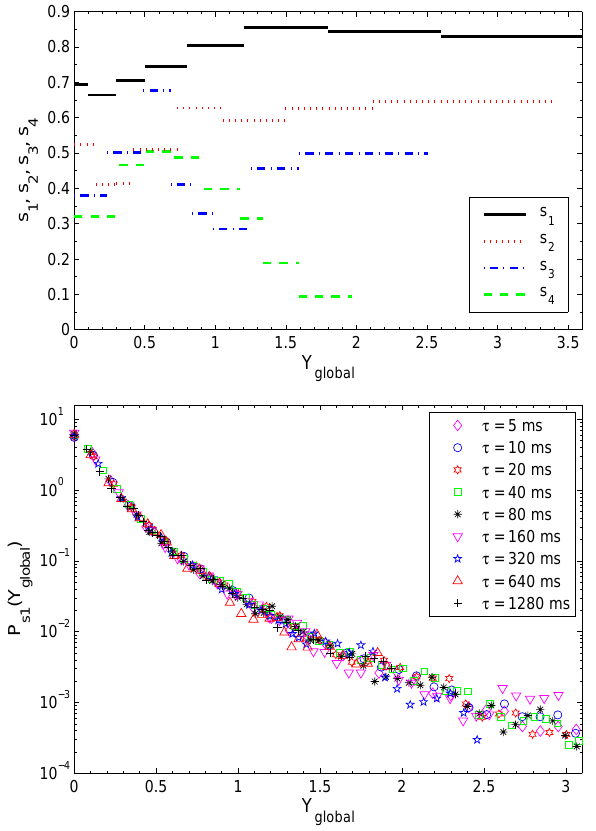
Fig. 9. (Top) The rank-ordered spectra s 1 (solid black), s 2 (dot- ted red), s 3 (dot-dashed blue), and s 4 (dashed green) as functions of Y global . (Bottom) Global scaling function P s 1 (Y global ) obtained from the PDFs at all the time scales of the four